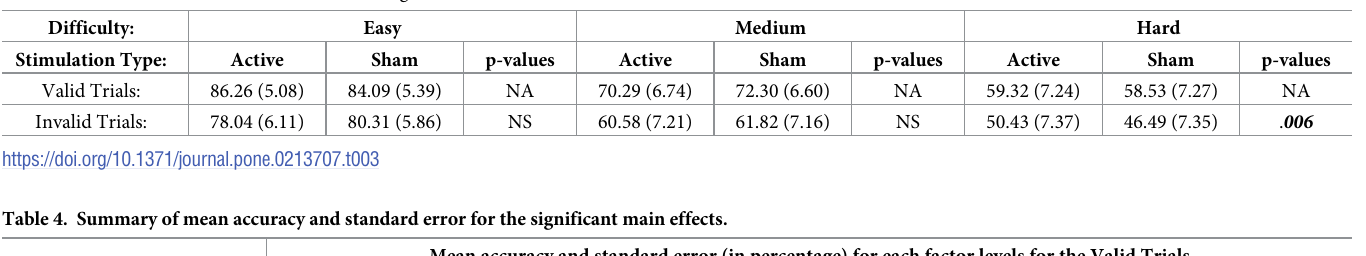
Table 3. Summary of mean accuracy and standard error. Accuracy for Valid and Invalid trials for each active and sham stimulation at each difficulty level (Easy, Medium and Hard) are presented. P-values represent the interaction between Difficulty and Stimulation Type derived from the ANOVA performed for the Invalid condi- tion. Interaction for the Valid condition was not significant and is not shown here.